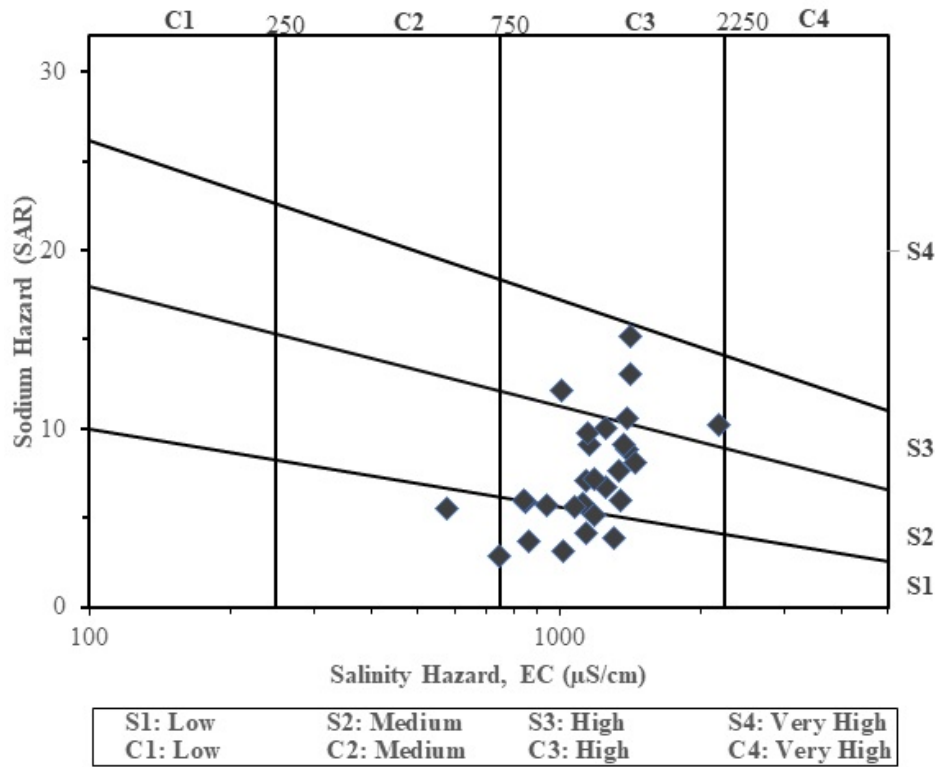
Figure 7. US Salinity classification for irrigation.